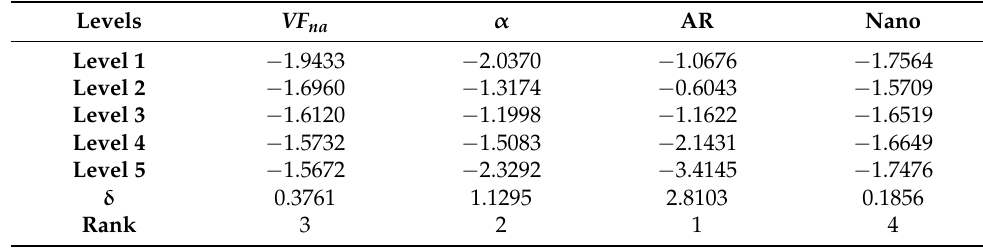
Table 6. The rank and S/N values of the design